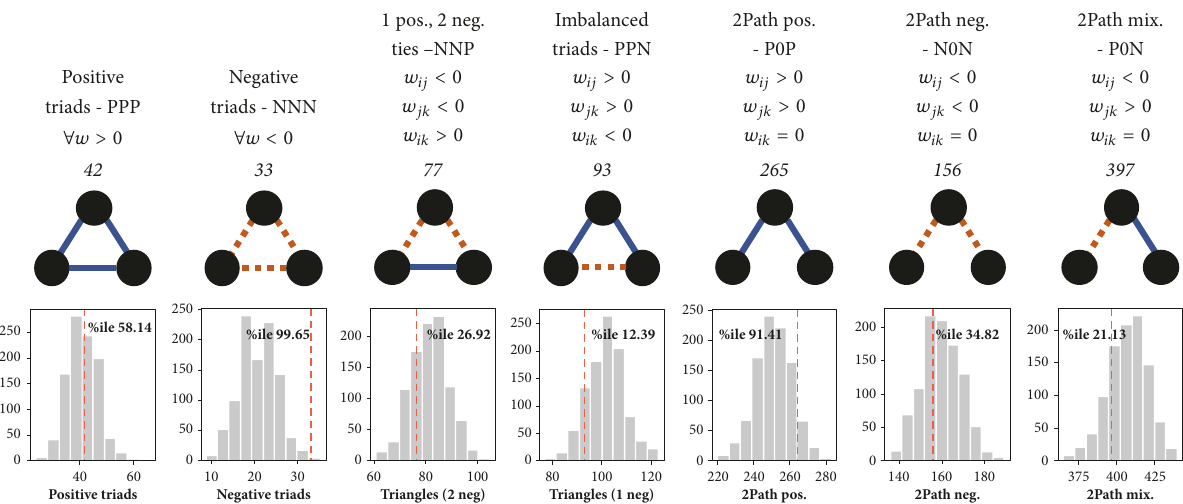
Figure 10: Signed motifs, name used in this study, the definition, schematic figure, and the figure showing distribution of motif frequencies in 1000 random networks with the same degree sequence and weight distribution and percentile value of the frequency of empirical network in that distribution.